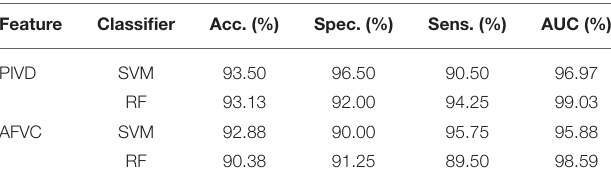
TABLE 2 | Results of the proposed acoustic model of speech emotional flatness in schizophrenia.